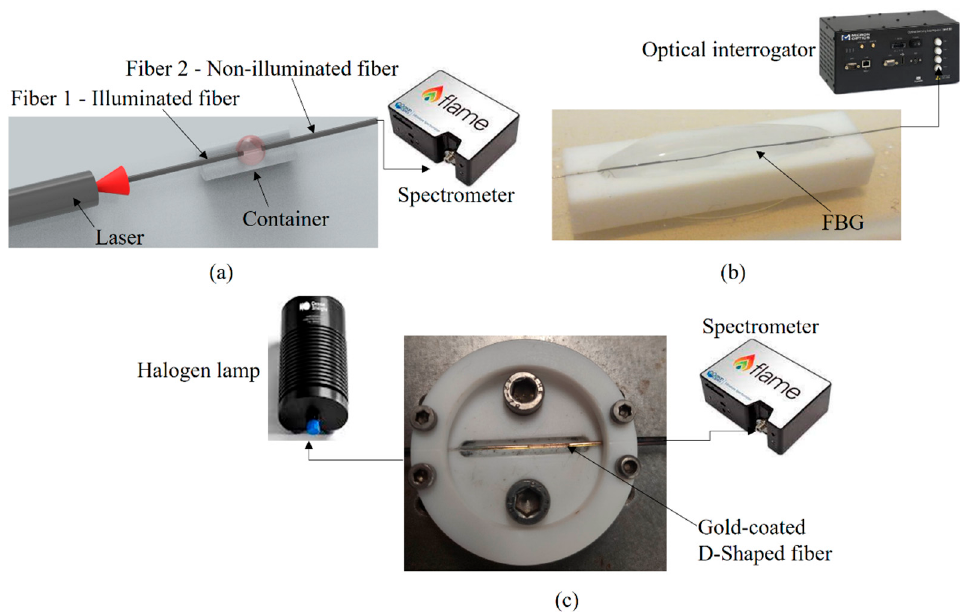
Figure 1. Experimental setup for ( a ) intensity, ( b ) FBG, and ( c ) SPR. For the FBG-based sensor, the uniform grating was inscribed in photosensitive single mode silica fiber. The uniform FBGs were produced using a pulsed Q-switched Nd:YAG laser system (LOTIS TII LS-2137U), emitting the fourth harmonic (266 nm) [30], with an emission power lamp energy of 26 J and measured pulse energy of 120 J with a repetition rate of 1 Hz. The laser beam profile was circular with the diameter around 8 mm and divergence less than 1.0 mrad. An effective focal length of 320 mm was used to focus the laser beam onto the fiber core. On the fiber surface, the beam produced a spot size of 8 mm wide and 30 µ m high. The phase mask employed was 10 mm long with a pitch of 1064 nm, designed for 266 nm irradiation, resulting in an FBG with Bragg wavelength of 1544 nm.